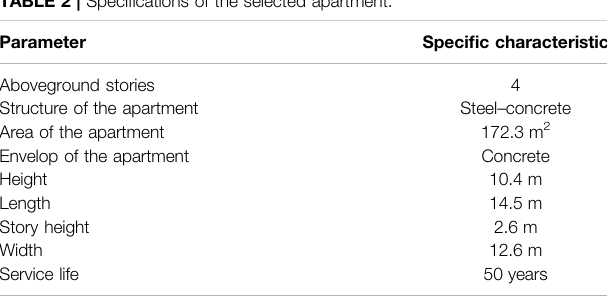
TABLE 2 | Speci fi cations of the selected apartment.